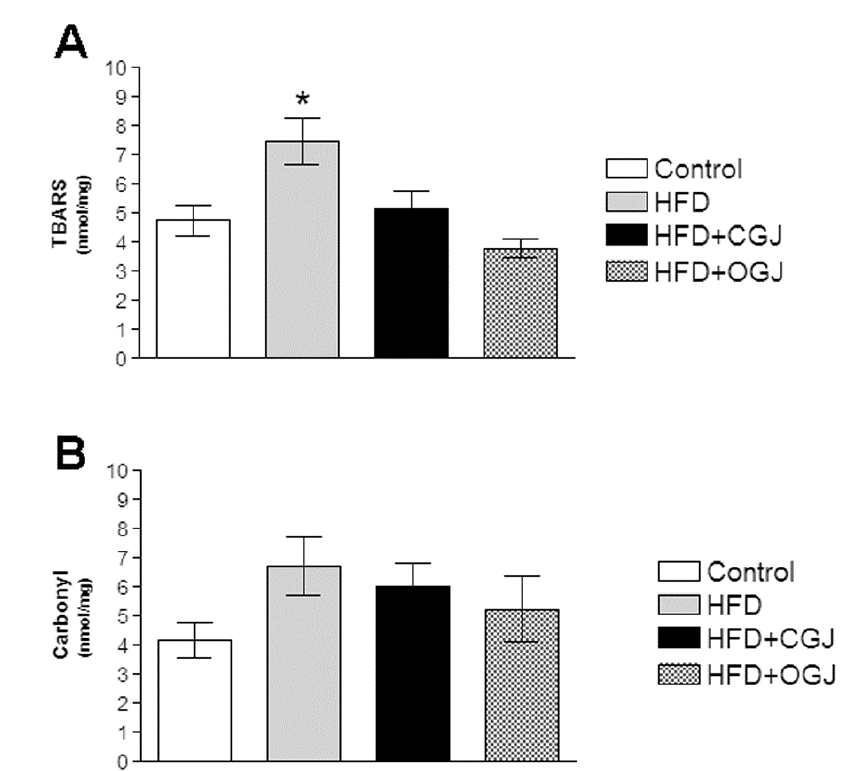
Figure 1. The effect of purple grape juices and high-fat diet on the formation of thiobarbituric acid-reactive substances (TBARS) ( A ) and carbonyl groups ( B ) in liver of rats. Values are the means ± SD for 8–10 samples in each group expressed as nmoL/mg. Statistically significant differences were determined by ANOVA followed by the Tukey test: * p < 0.05, different from the other groups. HFD, high-fat diet; CGJ, conventional grape juice; OGJ, organic grape juice.